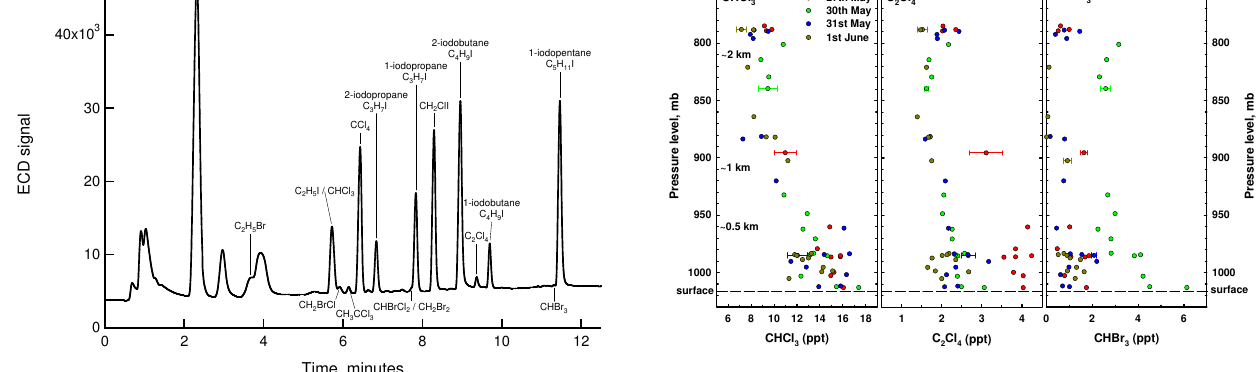
Fig. 10. Vertical profiles of CHCl 3 , C 2 Cl 4 and CHBr 3 mixing ratios (dry air mole fraction), measured near the Cape Verde Islands by µ Dirac aboard the NERC-ARSF Dornier 228 aircraft in May/June